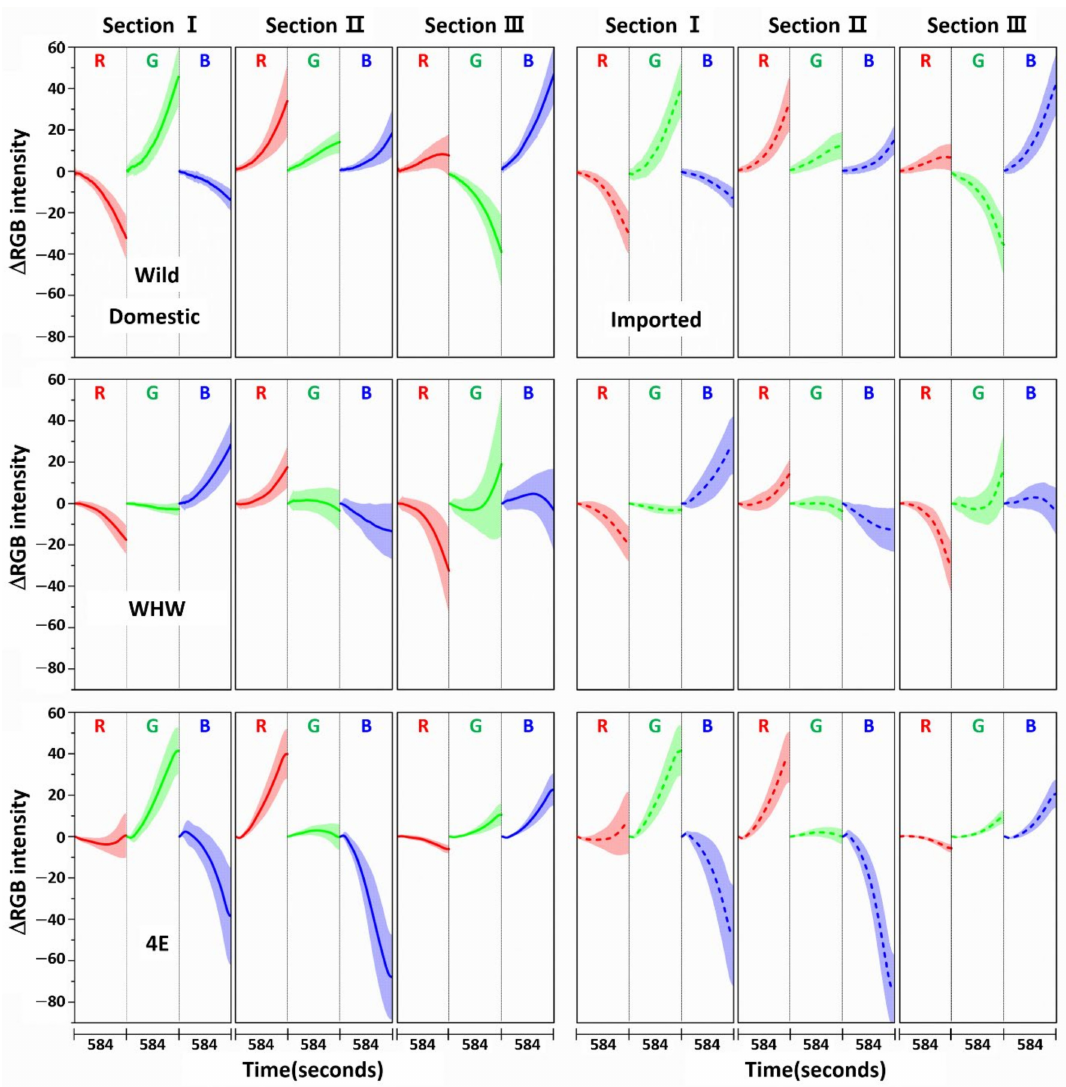
Figure 7. The same ∆ RGB intensities shown in Figure 6 with standard deviation (shading) for the domestic (left plot) and imported samples (right